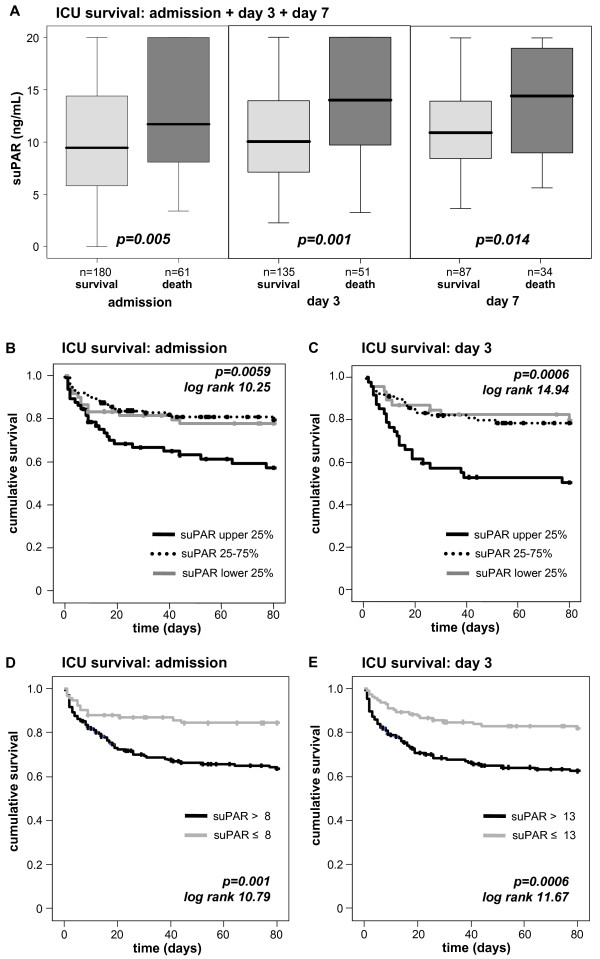
Prediction of ICU mortality by sequential suPAR serum concentrations. (A) Patients that die during the course of ICU treatment had significantly higher serum suPAR levels on admittance to ICU (P = 0.005), on Day 3 (P = 0.001) and Day 7 (P = 0.014) than survivors. (B and C) Kaplan-Meier survival curves of ICU patients are displayed, showing that patients with suPAR levels of upper quartile (on admission >15 ng/mL, on Day 3 > 15 ng/mL; black) had an increased short-term mortality at the ICU as compared to patients with suPAR serum concentrations of lower quartile (on admission < 6 ng/ml, on Day 3 < 7 ng/ml; grey) or middle 50% (dotted line). P-values are given in the figure. (D and E) Kaplan-Meier survival curves of ICU patients are displayed, showing that patients with high suPAR levels (on admission > 8 ng/mL, on Day 3 > 13 ng/mL; grey) had an increased short-term mortality at the ICU as compared to patients with low suPAR serum concentrations. P-values are given in the figure.